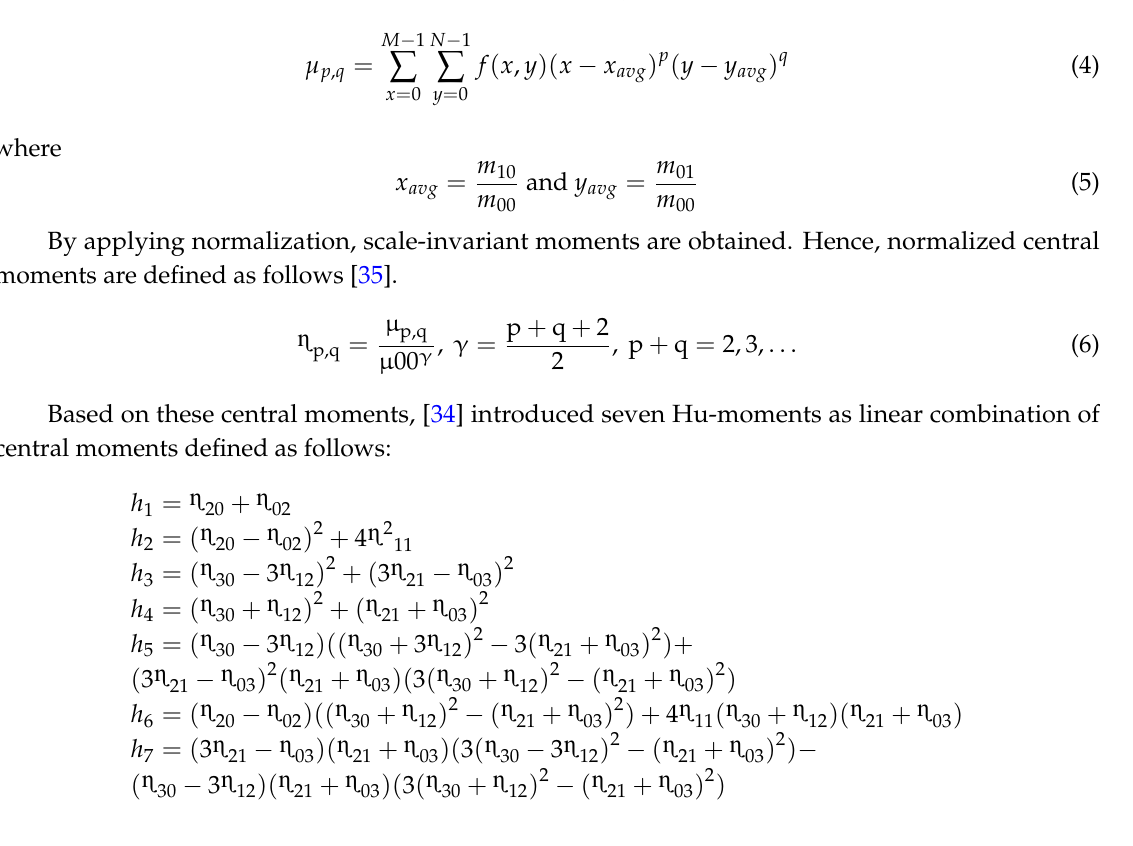
Figure 4. Example of division of silhouette into radial bins.